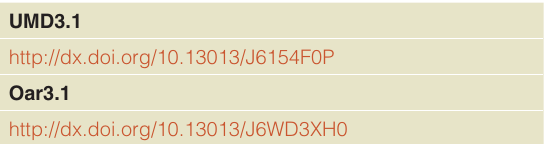
Table 4. Links to pages within the Intrepid Bioinformatics data management system.